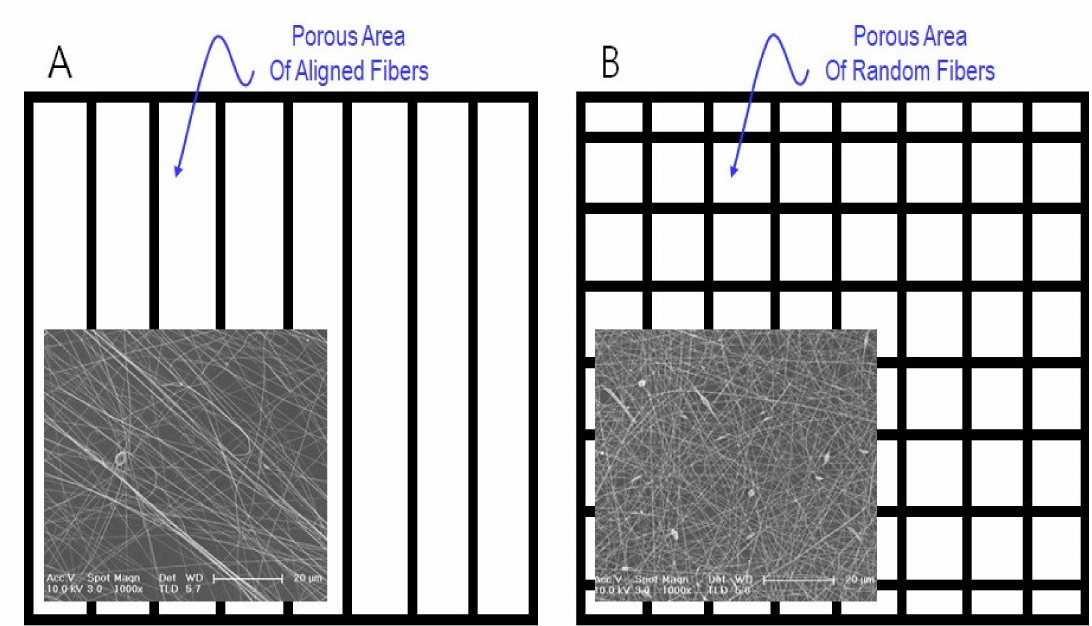
Figure 8. Cross-sections (dark area) of light scattering for both aligned fibers ( A ) and randomly distributed fibers ( B